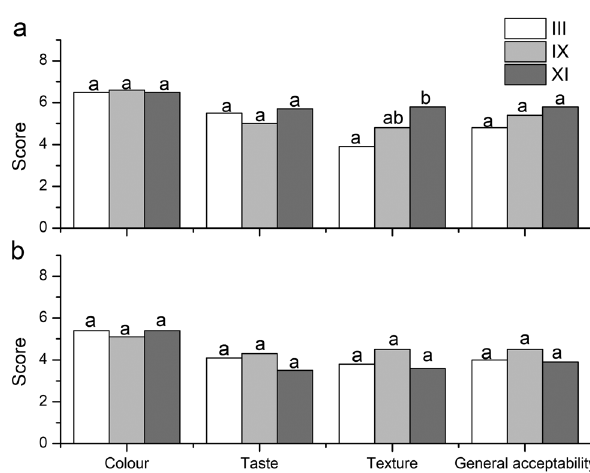
Figure 4: Photographs of ( a ) ingredients used in the preparations ( Figure 5: Scores of the colour, taste, texture, and general accept - ability obtained in the sensory analysis of ( a ) biscuits prepared with formulations III, IX, or XI with sugar and ( b ) biscuits prepared with formulations III and IX with sugar and algarrobo fl our ( s + AF )